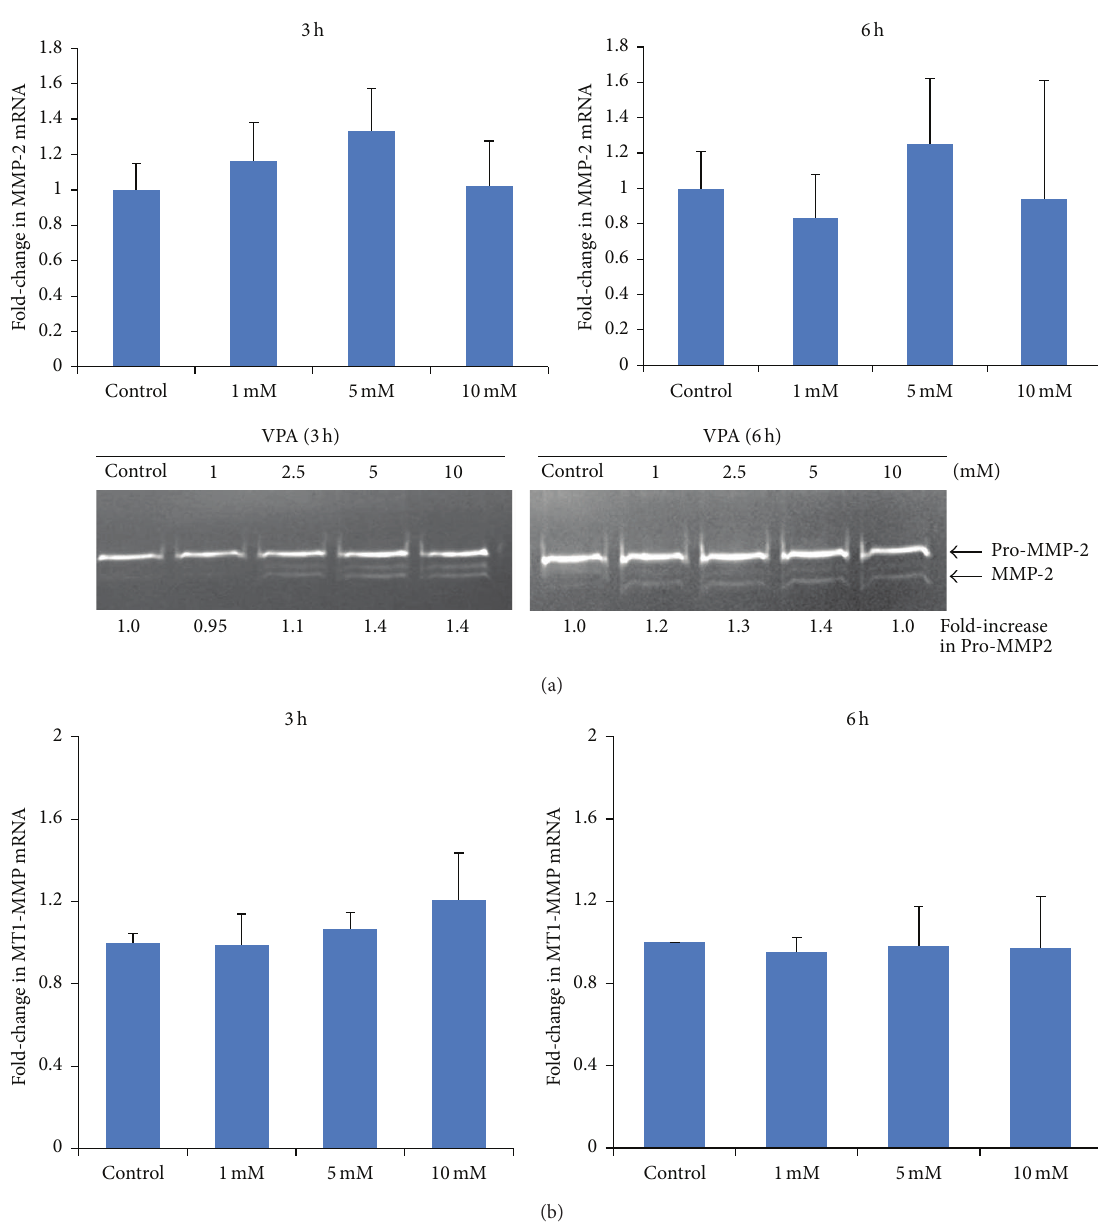
Figure 3: VPA increases MMP-2 but not MT1-MMP expression. CB-derived MSC were incubated with or without (control) 1, 2.5, 5, and 10mM VPA for 3 h or 6 h. (a) The expression of MMP-2 mRNA (top panel) was evaluated by real-time quantitative RT-PCR (qRT-PCR) using 18S mRNA as internal calibrator. The secretion of pro-MMP-2 and active MMP-2 was examined using zymography (bottom panel). The numbers at the bottom of the gel correspond to the fold-increase in pro-MMP-2 expression relative to control. (b) The expression of MT1-MMP mRNA as determined by qRT-PCR was not affected by treatment of the cells with